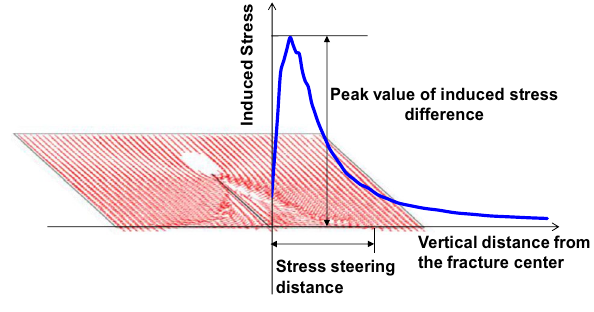
Fig. 2 The ISCR spatial definition